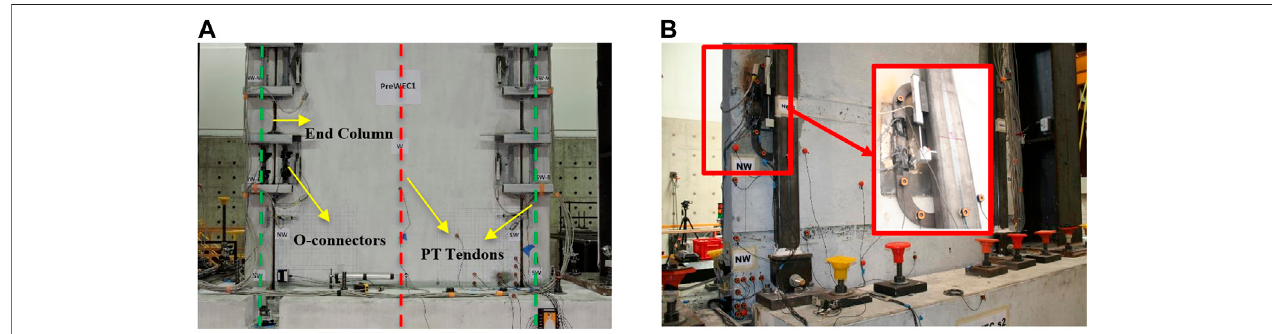
FIGURE 2 | PreWEC (PREcast wall with end columns) system: (A) Connectors at the ends of the wall panel; (B) Connectors on the sides of the wall panel.